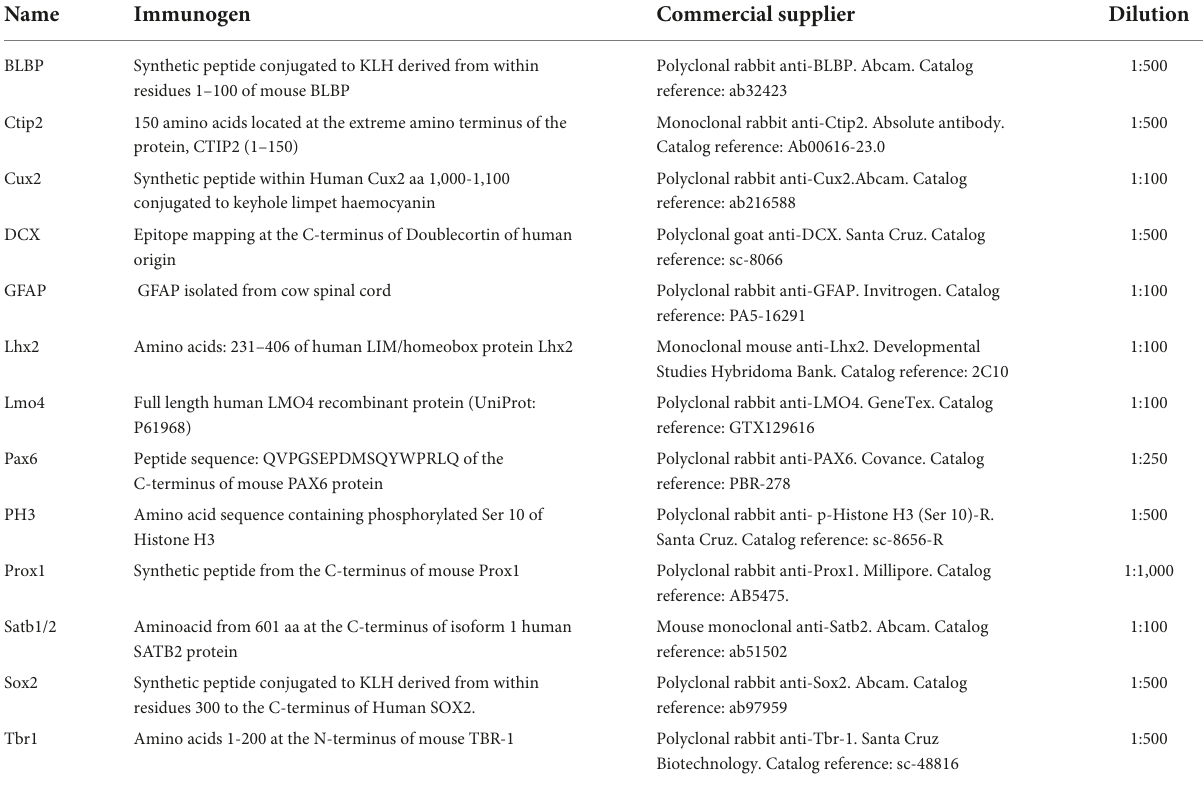
TABLE 1 List of primary and secondary antibodies used, immunogen, commercial supplier and dilution. Name Immunogen